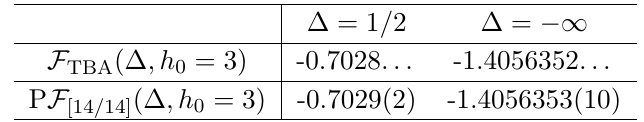
Table 3 . Comparison between the numerical values of the free energy at h 0 = 3 obtained by a direct numerical evaluation of the TBA equation and by using the analytic continuation given by P F (∆ , h 0 ) for ∆ = 1 / 2 and ∆ = −∞ . [14 / 14] while for N = 4 the Lagrangian of the two scalars at b 2 = 8 π reads